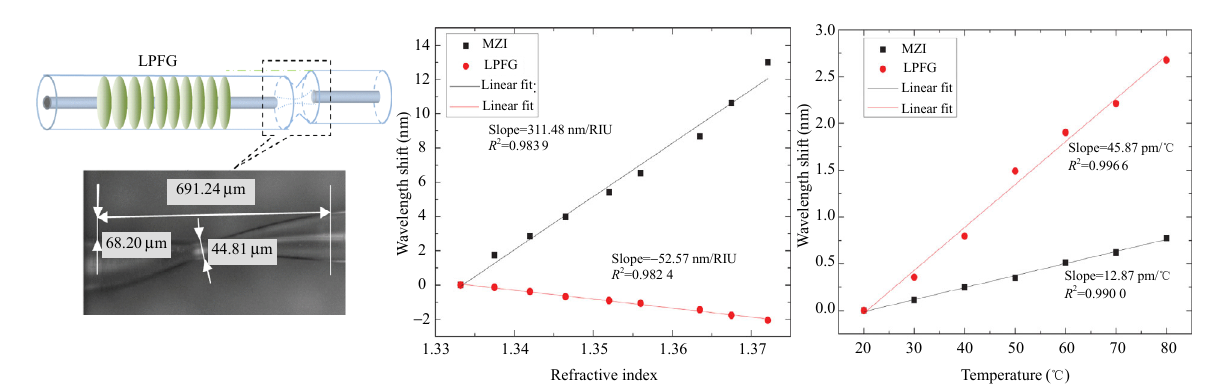
Fig. 6 Schematic diagram and SEM image of the cascaded fiber device and its RI and temperature responses